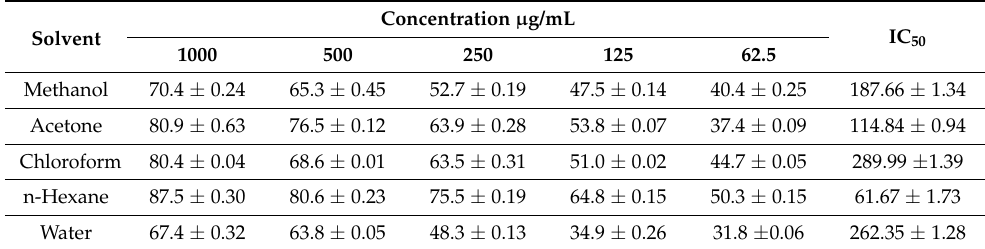
Table 3. IC 50 values of nitric oxide inhibition activity.